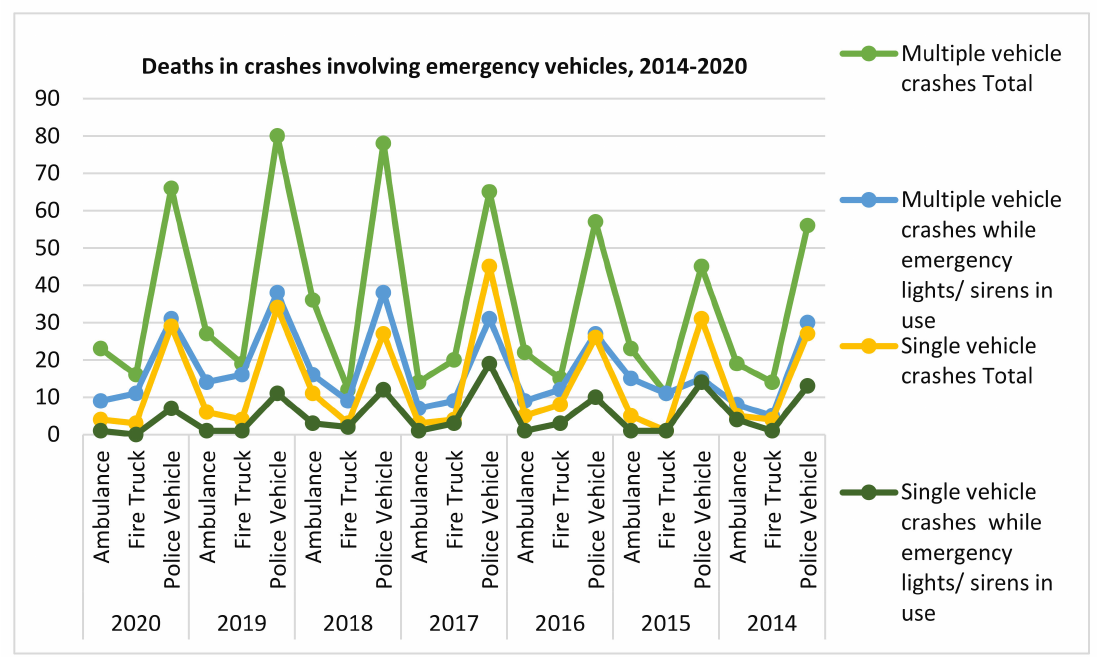
Figure 1. Death statistics of crashes involving EVs